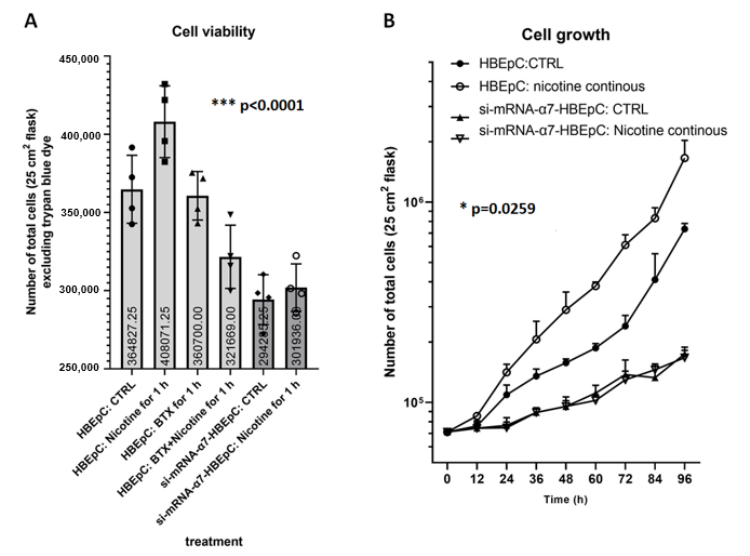
Figure 1. Cell viability ( A ) and cell proliferation ( B ) induced by nicotine in HBEpC and/or si-mRNA- α 7- HBEpC viability. ( A ): For cell viability, 7500 cells/cm 2 are plated in T25 flask (total cell number 187,000) and treated with nicotine 1 × 10 − 7 M, after 1 h cells are washed three times in PBS Ca 2+ and Mg 2+ free and then incubated in drug-free medium for additionally 48 h. Then, cells (detached or floating) are counted after staining with trypan blue dye. ( B ): For cell proliferation 7500 cells/cm 2 are plated in T25 flask and treated with nicotine every 48 h. Cells are detached and viable cells are counted every 12 h. Experiments are performed at least two times in triplicate. Statistical significance is analyzed with one-way ANOVA with multiple-comparison and post hoc test with Bonferroni correction.